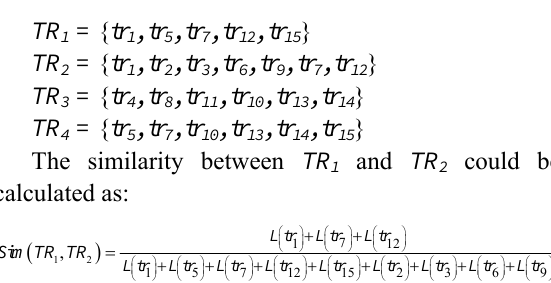
Fig. 3. Trajectory and sub-trajectory in road